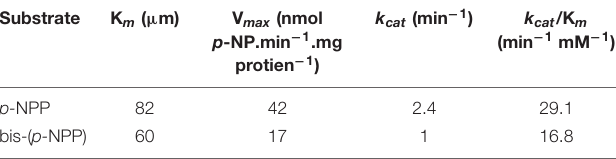
TABLE 1 | Kinetic parameters values of rRv2577.